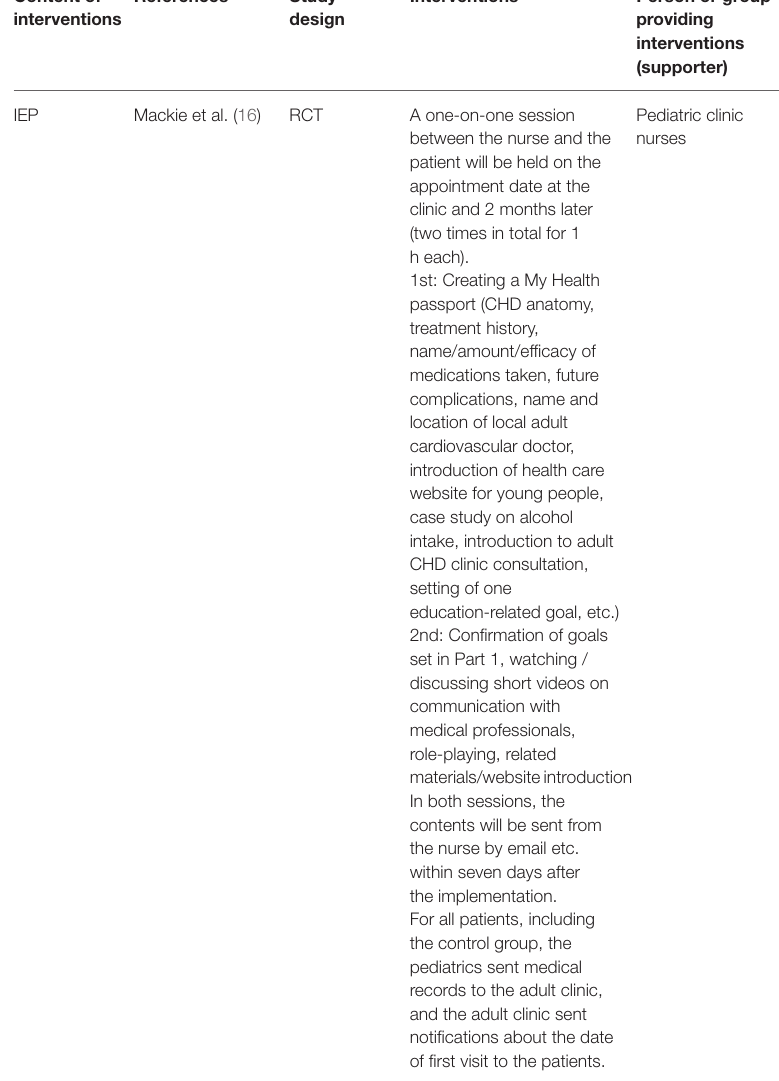
TABLE 1 | List of study design and intervention contents of review papers. Content of interventions